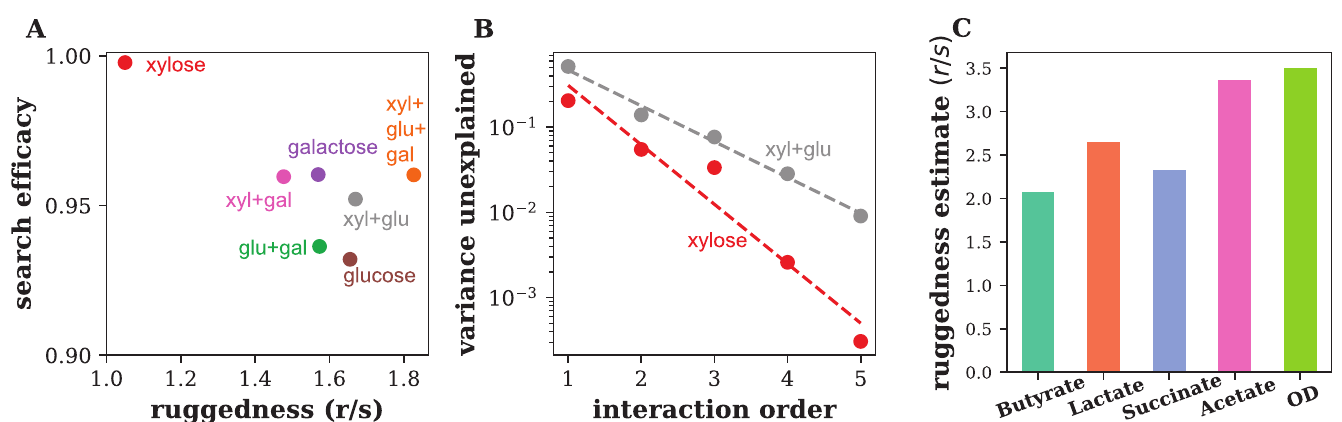
Fig 11. Ruggedness of experimental landscapes. (A) shows the ruggedness and search efficacy in the seven environments studied in Ref. [32] labeled by the carbon sources used. There is an apparent anticorrelation between the efficacy and ruggedness, but it does not reach statistical significance ( p = 0.29). Note that the range of ruggedness and search efficacy is quite narrow presumably because of the overlap in the carbon sources in different environments and the choice of species that grow well on these sugars. Nevertheless, the search efficacy was highest on the least rugged landscape (xylose). Search efficacy and ruggedness were anti-correlated with ruggedness on the three pure carbon sources as well. (B) The decrease in the variance unexplained with increasing model complexity shows behavior similar to that of the simulated landscapes in Fig 6. Dashed lines in panel B show a linear fit on the semi-logarithmic plot.(C) The estimated ruggedness of experimental landscapes of five different community functions studied in Ref. [65]. The ruggedness was estimated of the 25 species landscape was estimated from experimental measurements of community function of 577 different species combinations.